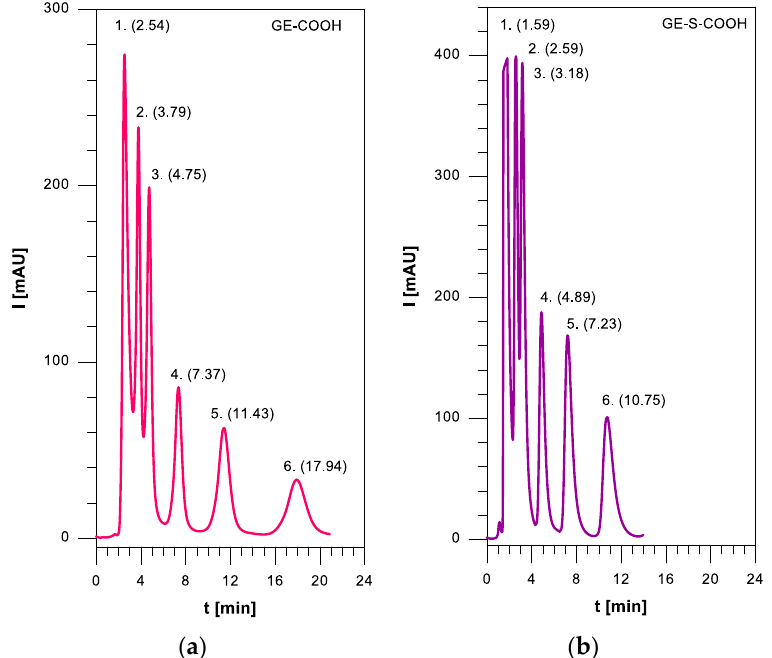
Figure 8. Separation of the mixture of homologous N -anilines, ACN-buffer (35:65, v:v): ( a ) GE-COOH; ( b ) GE-S-COOH.